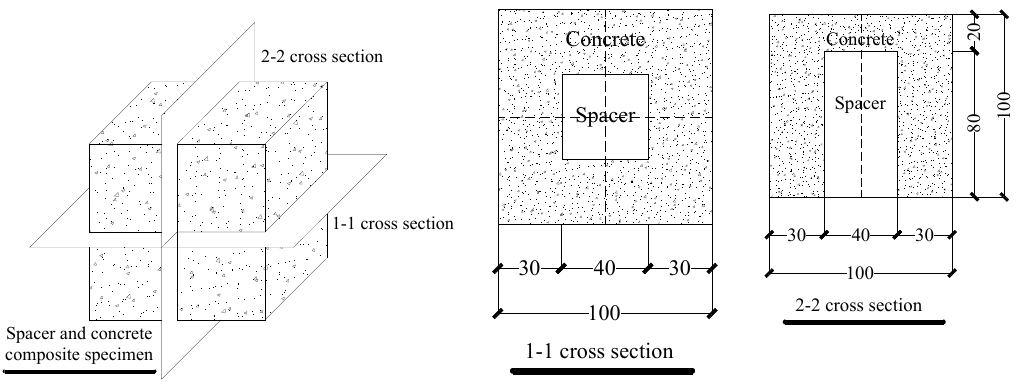
Figure 3. Spacer and concrete composite cross-sections (Unit: